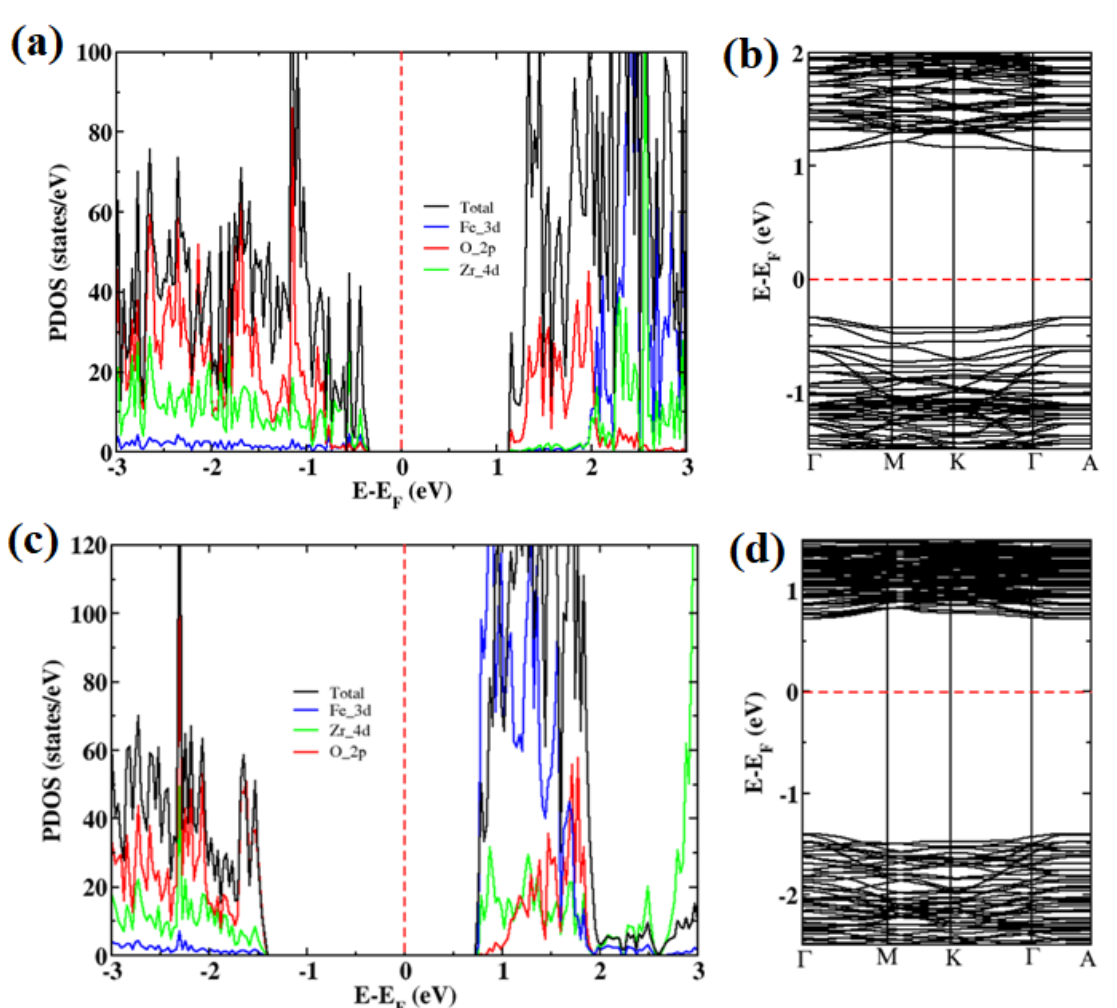
Figure 5. PDOS and band structure of Zr-doped {0001} α -Fe 2 O 3 surface ( a , b ) and (2Zr)-doped {0001} α -Fe 2 O 3 surface ( c , d ). The Fermi level is set to zero.